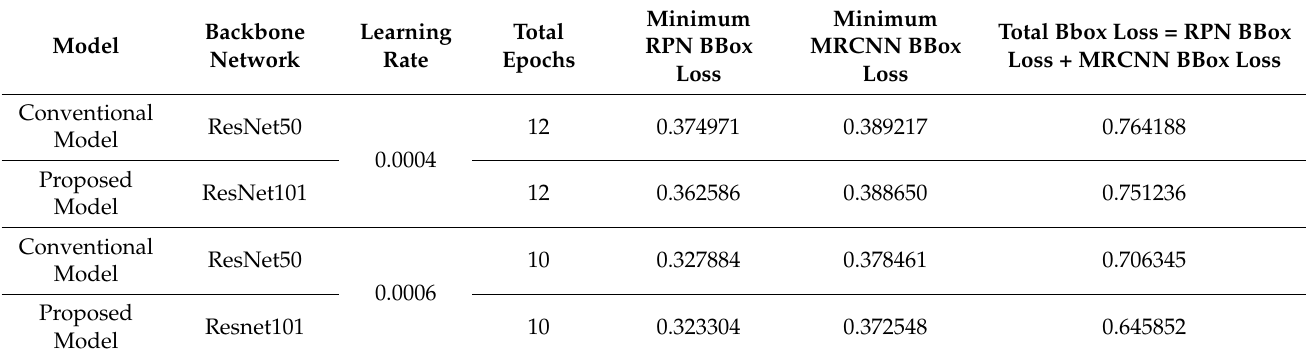
Table 8. BBox loss values for validation data with different learning rates and